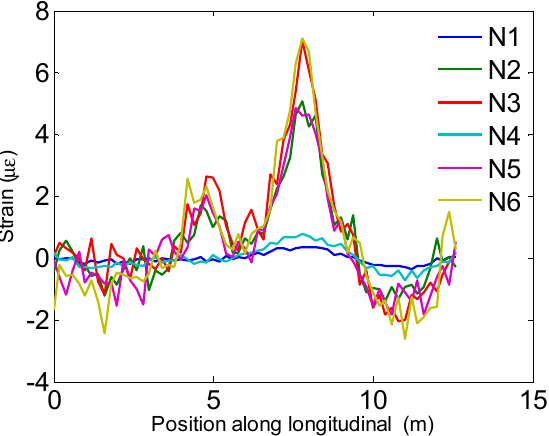
Figure 6. The strain response of the measurement point with 20% noise.